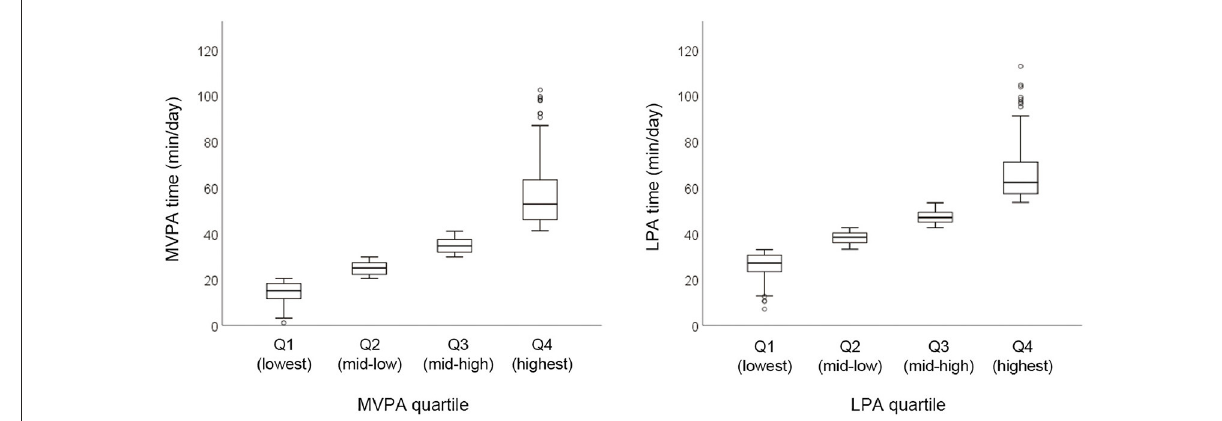
FIGURE2 Physical activity time spent in MVPA and LPA in the overall sample. Graphs represent median and range per quartile. MVPA, moderate- to vigorous-intensity physical activity; LPA, low-intensity physical activity; Q, quartile of physical activity.